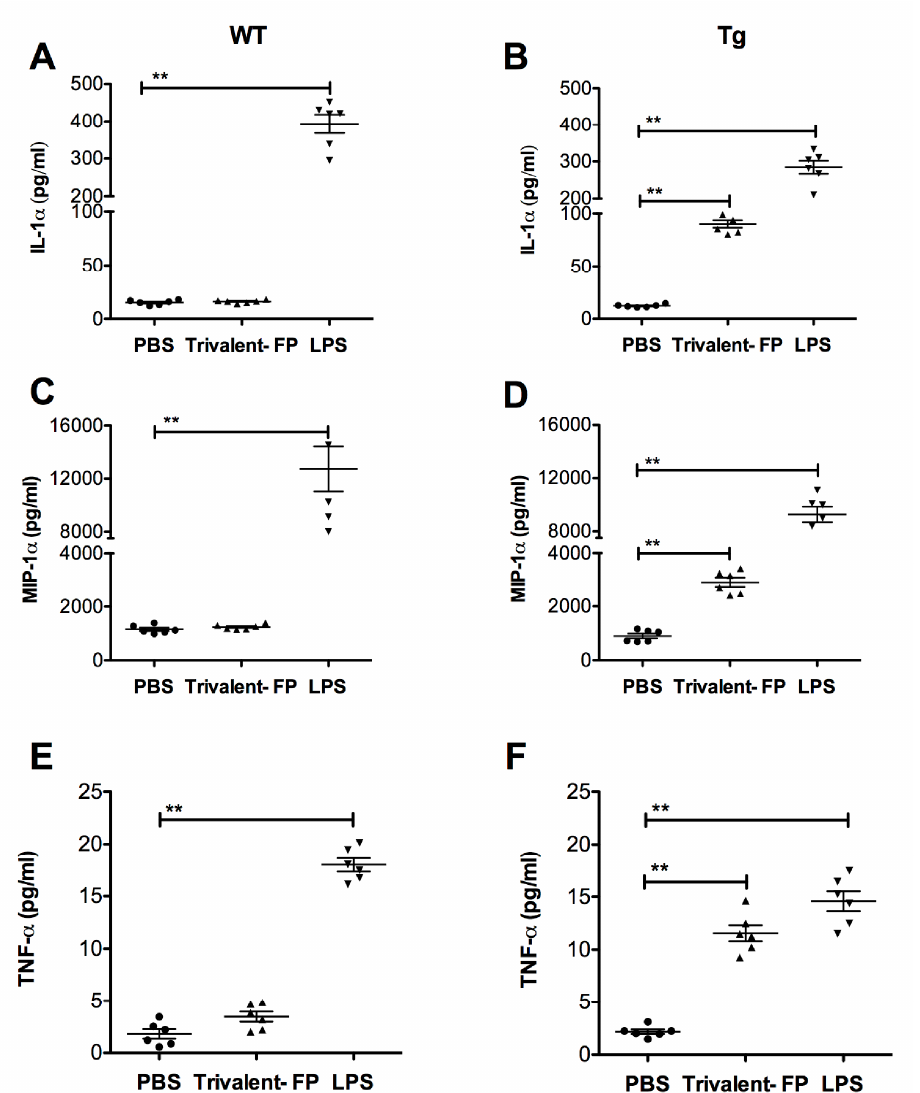
Figure 6. Trivalent-FP induced cytokine release by pulmonary cells in a hFc γ RI-dependent manner: single cell preparation from lungs of WT (wild type) ( A , C , E ) or Tg (transgenic) ( B , D , F ) mice were treated with PBS, 50 µ g Trivalent-FP, or 100 ng lipopolysaccharide. Forty-eight hours following the treatment, cytokines were evaluated in culture supernatants using bioplex multiplex assay. Mean ± SE of data from two independent experiments is shown ( n = 6 / group, ** p = 0.01). Statistical significance between indicated groups was evaluated by Mann–Whitney nonparametric test.